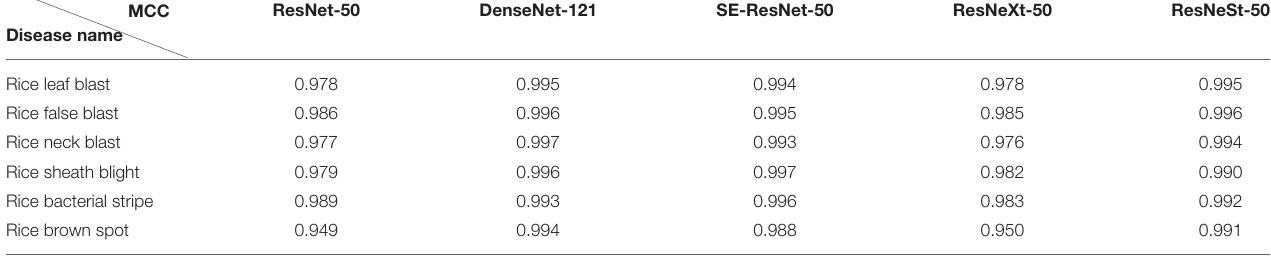
TABLE 2 | MCC values of the five different submodels.